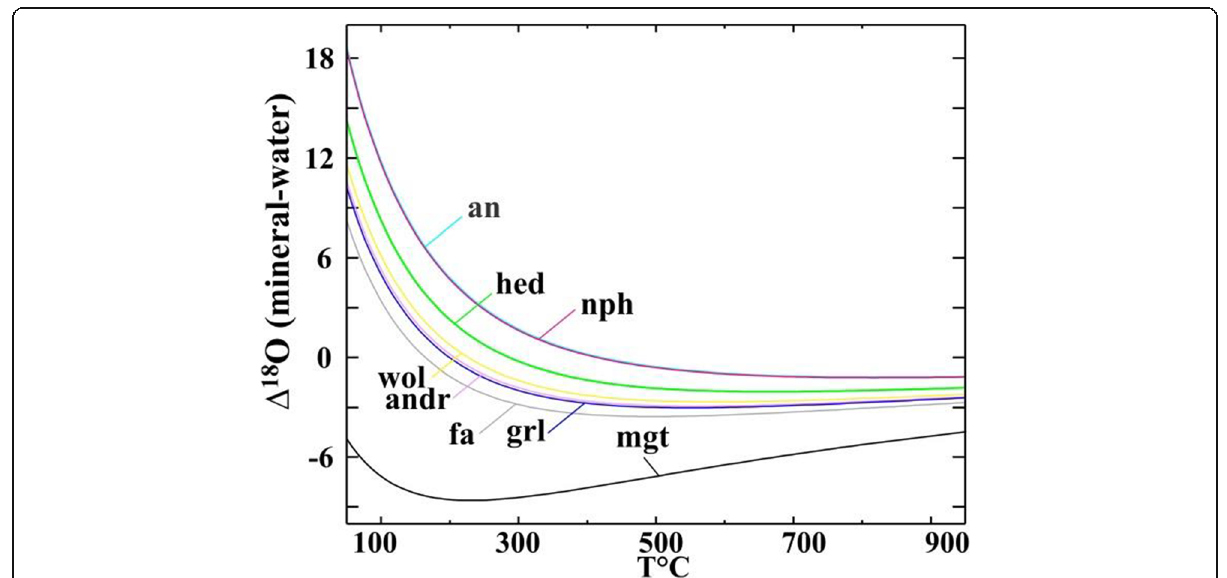
Fig. 20 Calculated oxygen-isotope fractionations for anhydrous silicate-water and magnetite-water as a function of temperature (Zheng 1991,